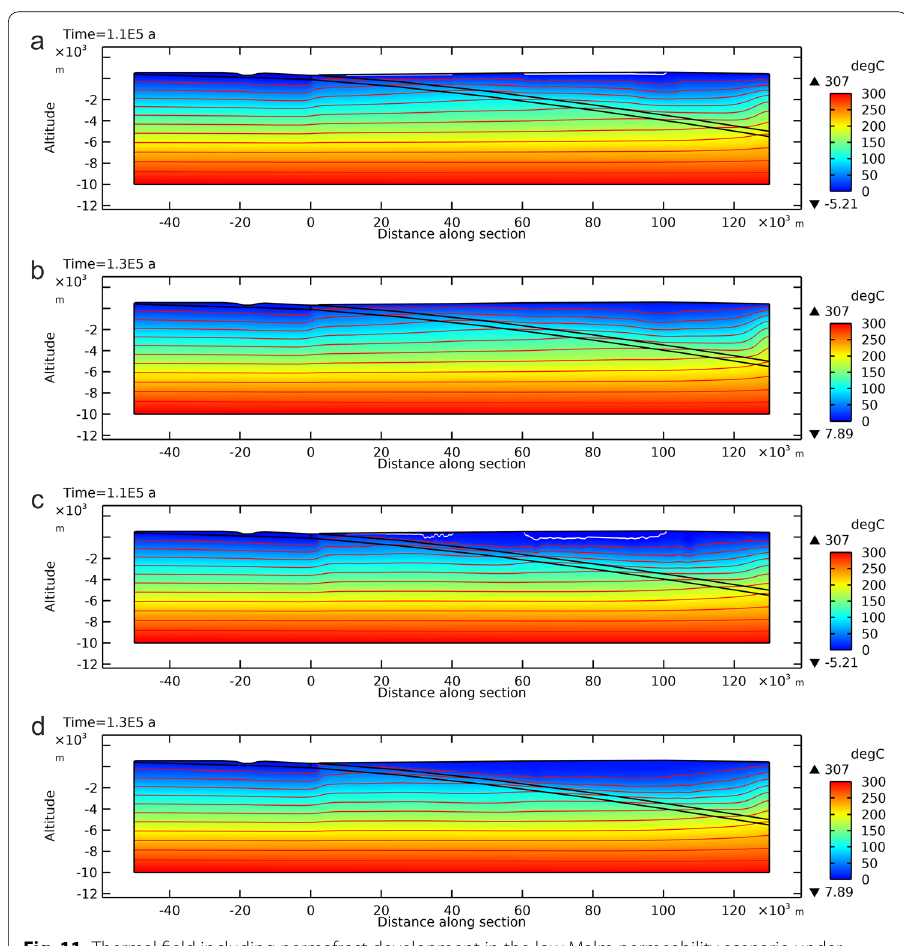
Fig. 11 Thermal field including permafrost development in the low Malm permeability scenario under paleoclimatic conditions (i.e. model run D introduced in Fig. 3) a 20 ka ago (time 1.1E5 a) and b at present = (time 1.3E5 a), and in the high Malm permeability scenario under paleoclimatic conditions (i.e. model run E) = c 20 ka ago (time 1.1E5 a) and d at present (time 1.3E5 a). Red lines are isotherms at 25 °C intervals. White = = line marks base of permafrost (0 °C). Vertical exaggeration equals